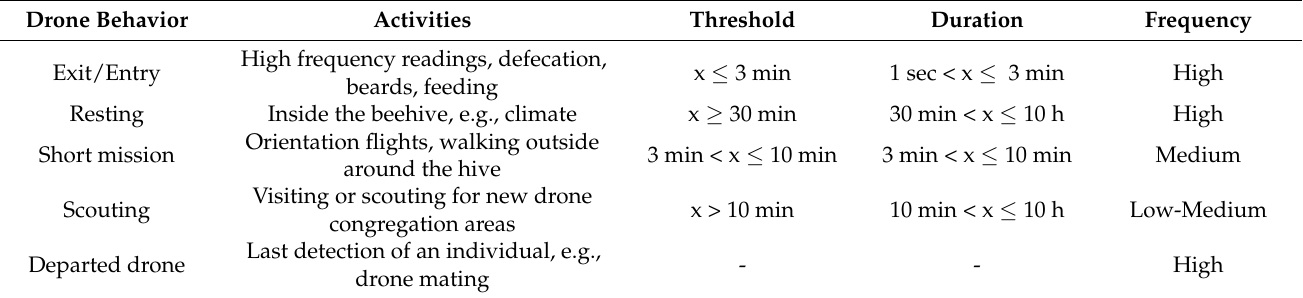
Table 1. Inputs to generate scripts in R to illustrate the activity of a drone in a day, including an interpretation of the events associated with the activity of each bee